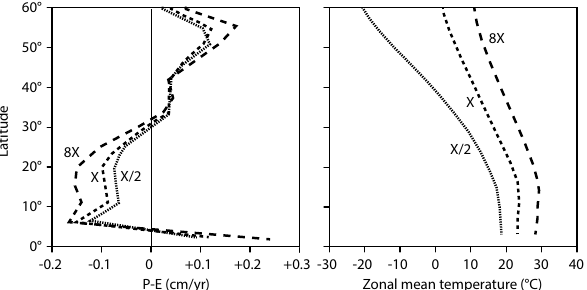
Fig. 5. Latitudinal distributions of (left panel) zonal average pre- cipitation minus evaporation ( P − E ) and (right panel) zonal mean surface air temperature based on a general circulation model with an annual mean insolation and idealized geography obtained for vari- ous multiples of atmospheric p CO 2 (pre-industrial) values, shown here ranging from one-half ( X /2) to eight fold (8 X ) (extracted from Figs. 4 and 19 in Manabe and Bryan,